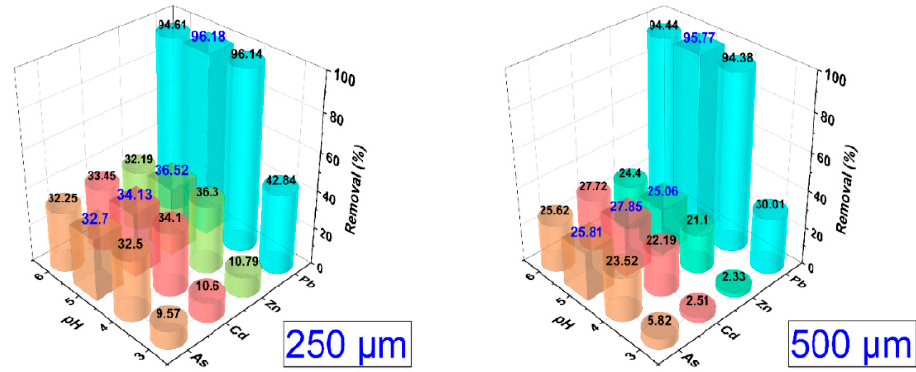
Figure 6. Influence of pH on the removal of heavy metals for the 250 and 500 µ m fractions of the mixed treatment